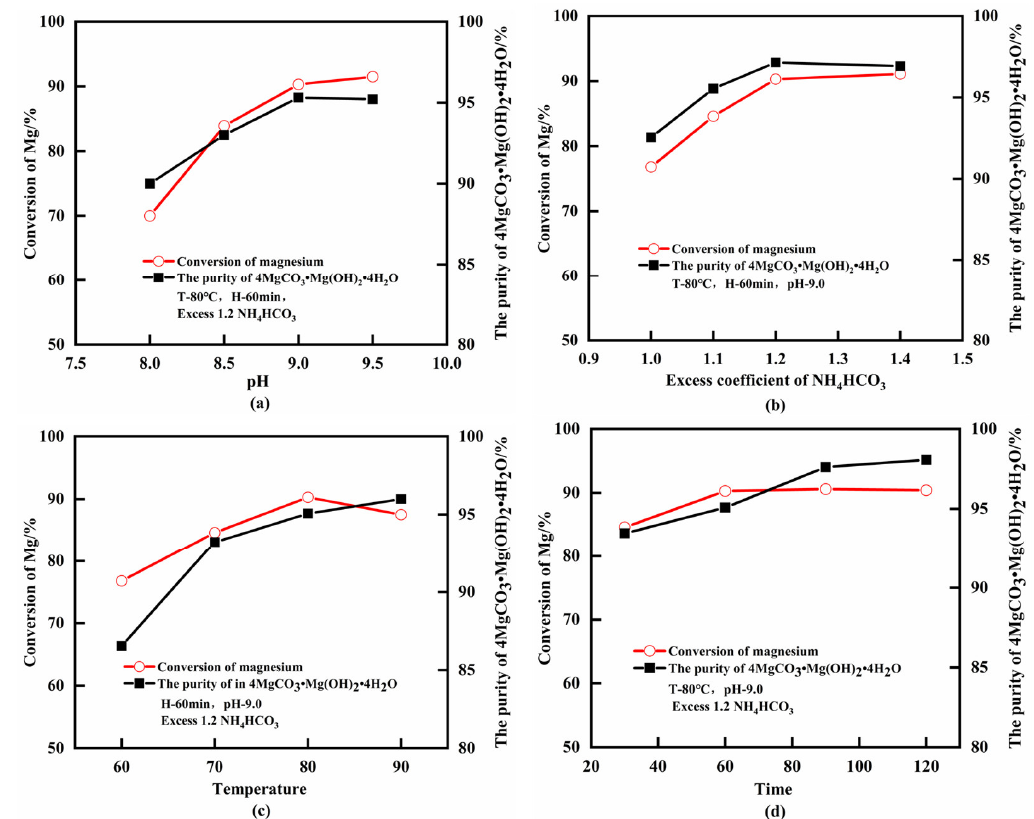
Figure 9. Effect of the main process conditions on magnesium precipitation efficacy ( a ) pH; ( b ) excess coefficient of NH 4 HCO 3 ; ( c ) temperature; ( d ) time. The purity of the precipitated products was calculated by the content of Mg found in the obtained precipitate vs the theoretical amount of Mg in 4MgCO 3 •Mg(OH) 2 •4H 2 O.